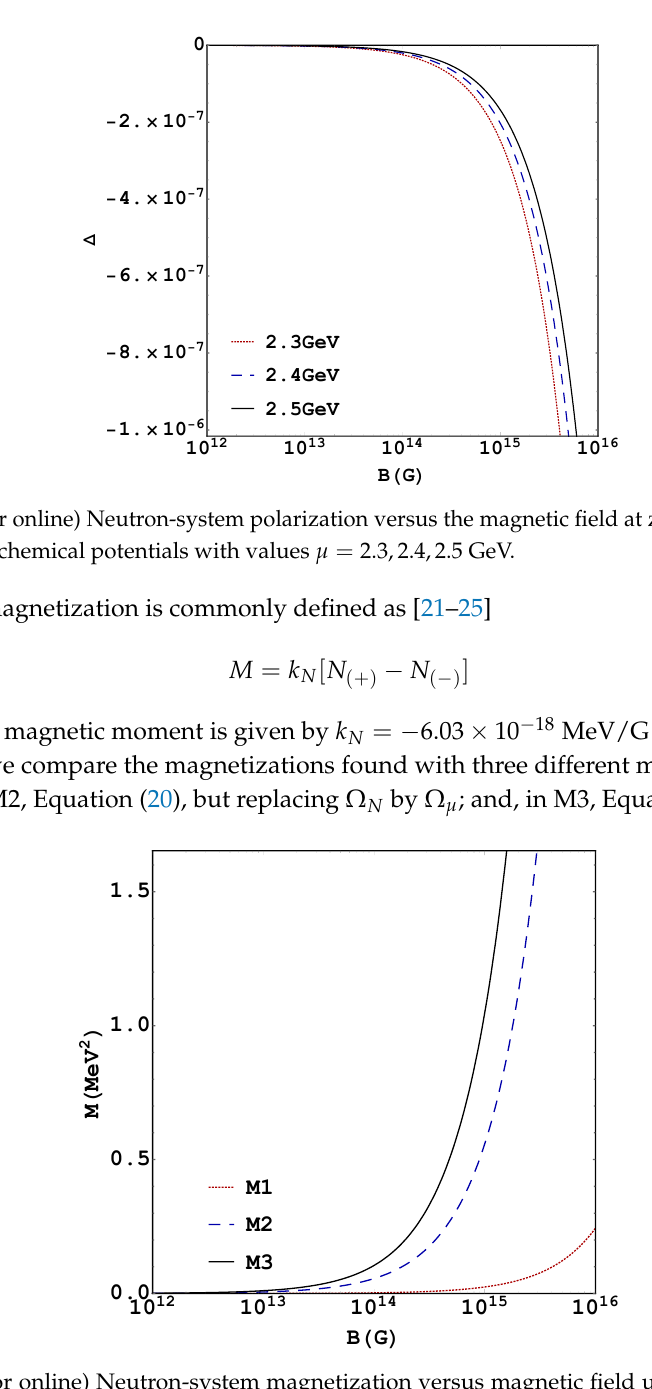
Figure 7. (Color online) Neutron-system magnetization versus magnetic field using three different formulations. In M1, we use Equation (28); in M2, Equation (20), but replacing Ω N by Ω µ ; and, in M3, Equation